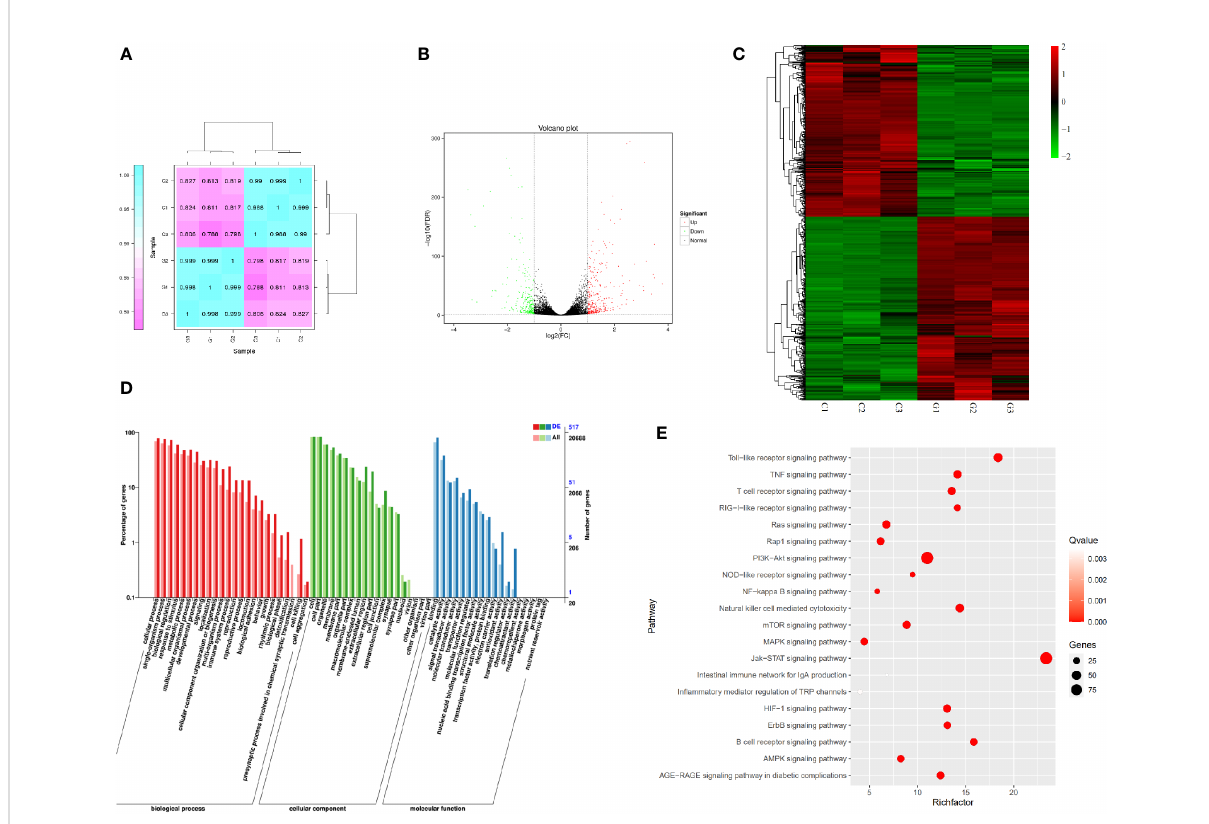
FIGURE 6 (A) Heat map of expression correlation of samples in different groups. (B) Differential gene expression volcano map. (C) Differential gene expression heat map. (D) Statistical chart of GO annotation classi fi cation of differentially expressed genes. (E) Bubble plot of differentially expressed genes KEGG